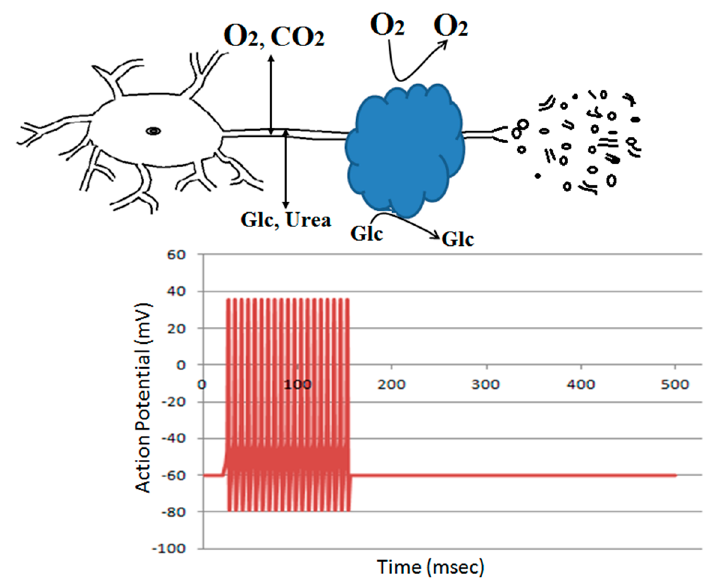
Figure 6. Denied Access Model. The neurite regions surrounded by amyloid gel plaques are denied from accessing to nutrient and signaling molecules as well as to the drainage pathways for metabolic wastes. This denied access leads to the inhibition of the action potential propagation and eventually the degeneration of the disused neurites [10,31].